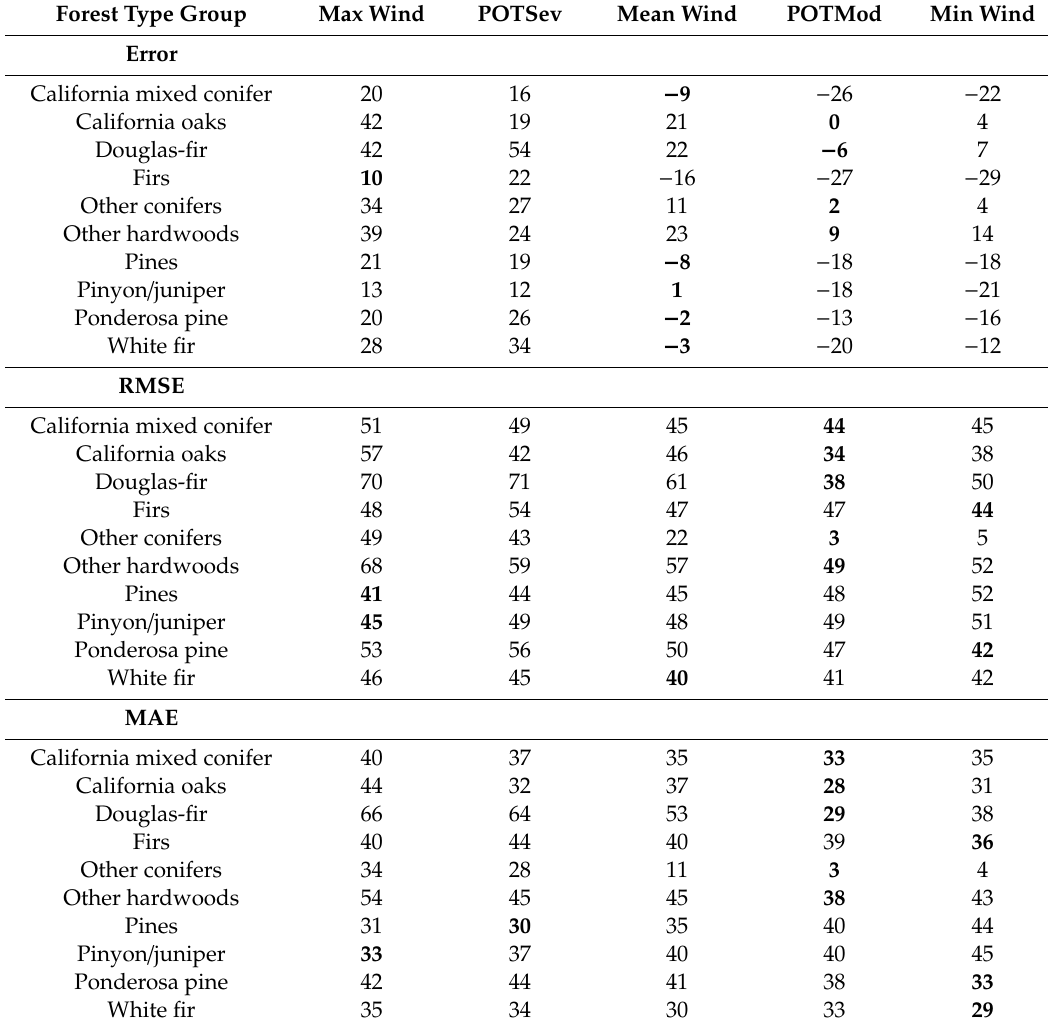
Table 6. Mean fire-induced mortality as a percent of pre-fire, live tree basal area, mean error, root mean square error (RMSE), and mean absolute error (MAE) by weather scenario for each forest type group, with errors closest to zero for each type group in